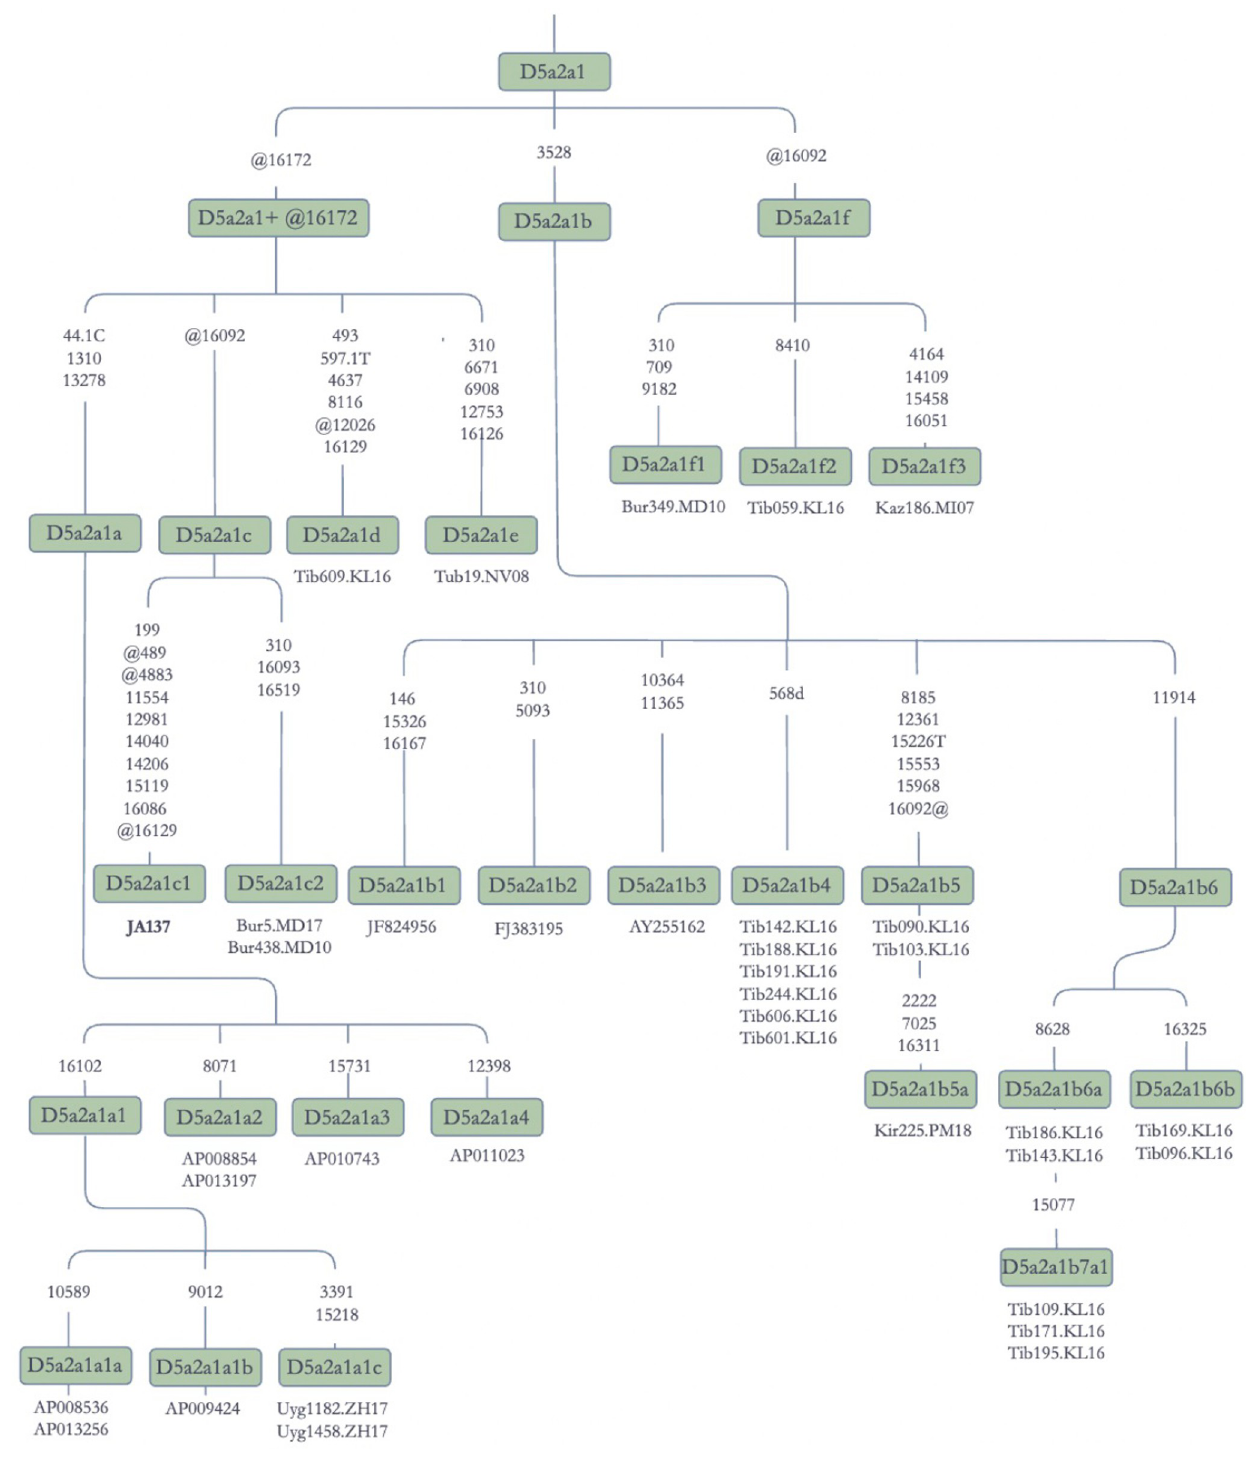
Fig 10. Schematic phylogenetic tree for the haplotype D5a2a1. Note: Bur: Buryat; Kaz: Kazak; Kir: Kirghiz; Tib: Tibetan; Uyg: Uyghur; The following sequences were obtained from the Phylotree Build 17.0 [46]: AP013256, AP008854, AP013197, AP010743, AP011023, AP008536, AP013256, and AP009424 are Japanese sequences; JF824956 is from China, but unknown ethnic origin; FJ383195 is from India; AY255162 is a Han Chinese sequence.